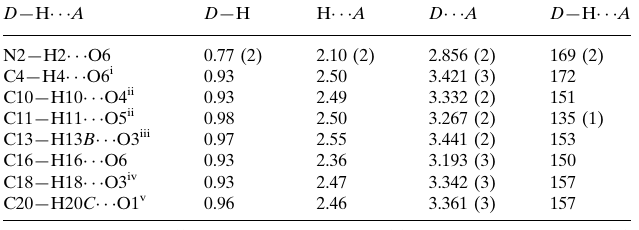
Data collection Bruker SMART APEX CCD area- detector diffractometer Absorption correction: multi-scan ( SADABS ; Sheldrick, 2008)